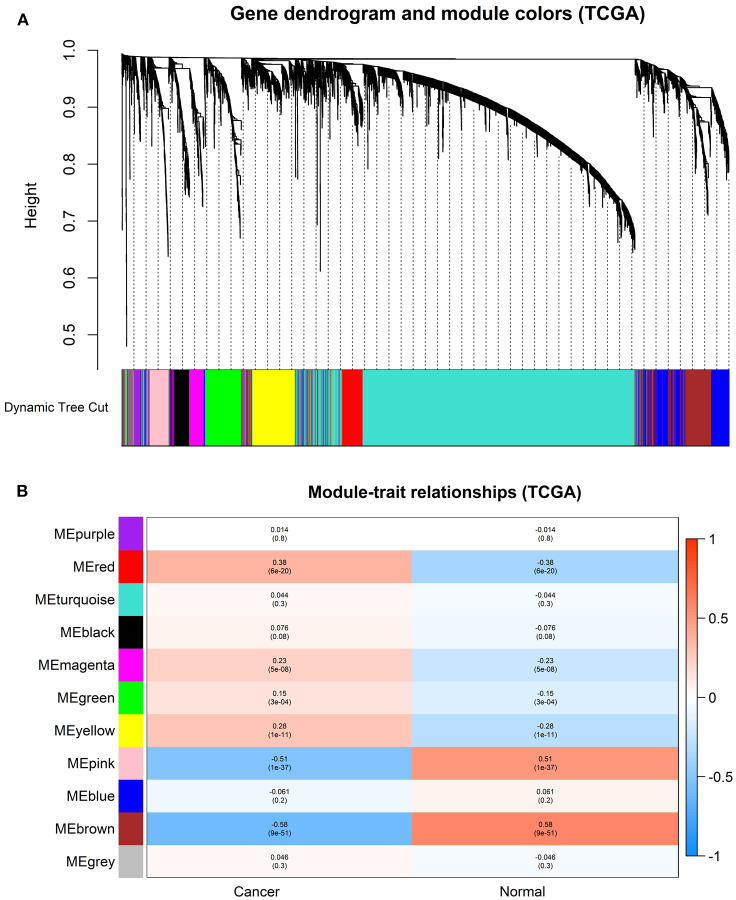
Identification of modules associated with the clinical information in the TCGA-HNSCC dataset. (A) The Cluster dendrogram of co-expression network modules was ordered by a hierarchical clustering of genes based on the 1-TOM matrix. Each module was assigned different colors. (B) Module-trait relationships. Each row corresponds to a color module and column corresponds to a clinical trait (cancer and normal). Each cell contains the corresponding correlation and P-value.